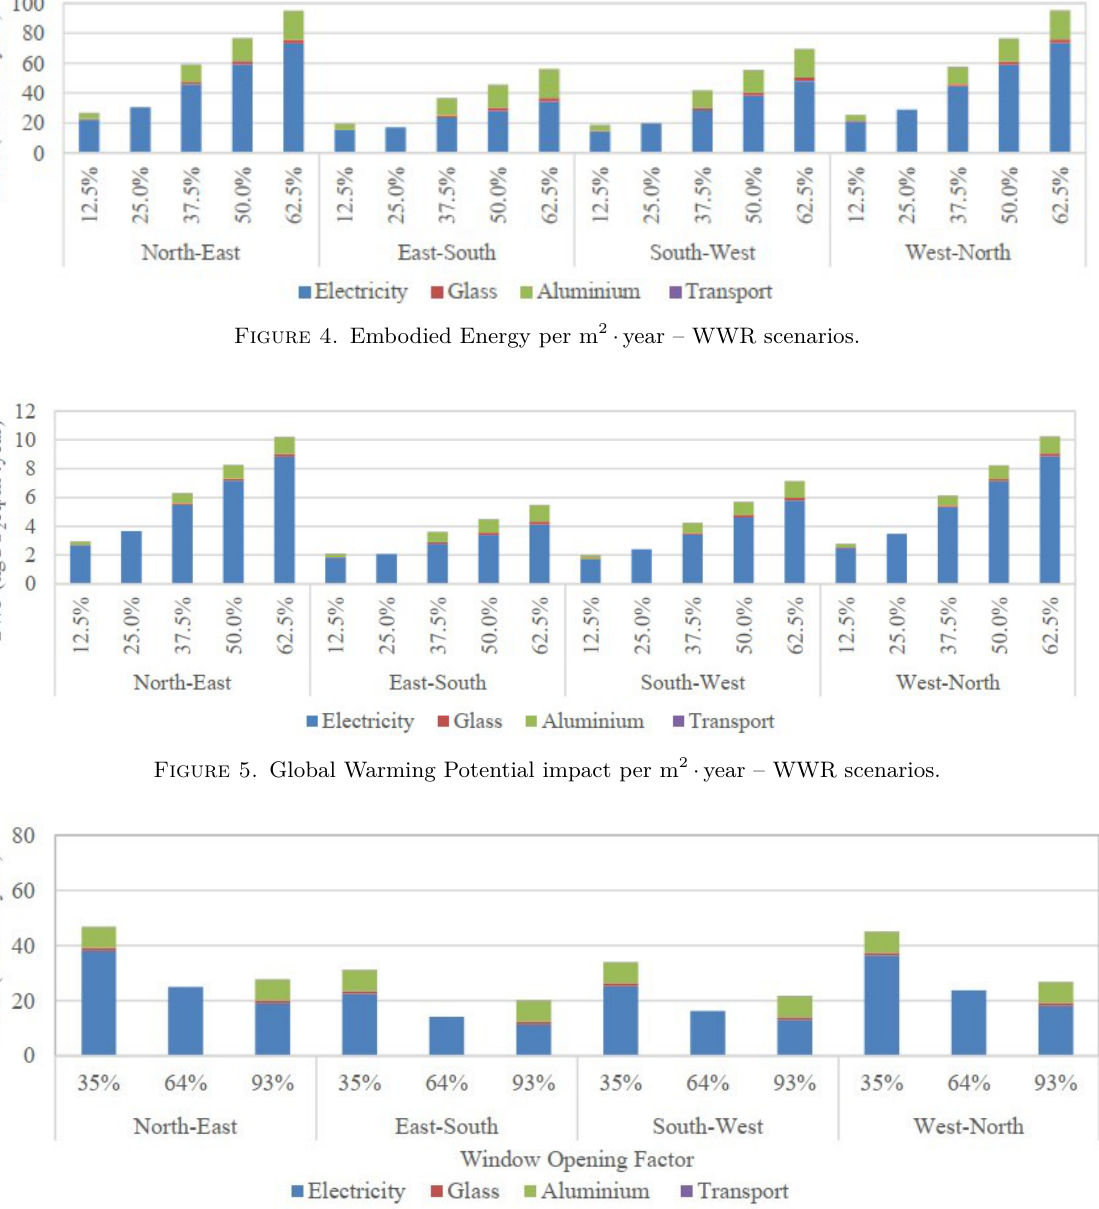
Figure 6. Embodied Energy per m 2 · year – window opening factor scenarios.